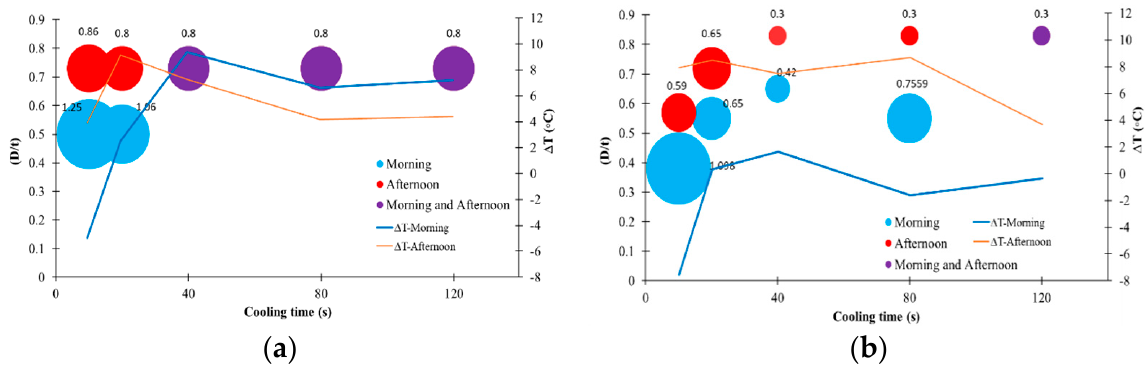
Figure 10. Characterization of the defects detected when the heating time was 40 s on the ( a ) east side and ( b ) west side.